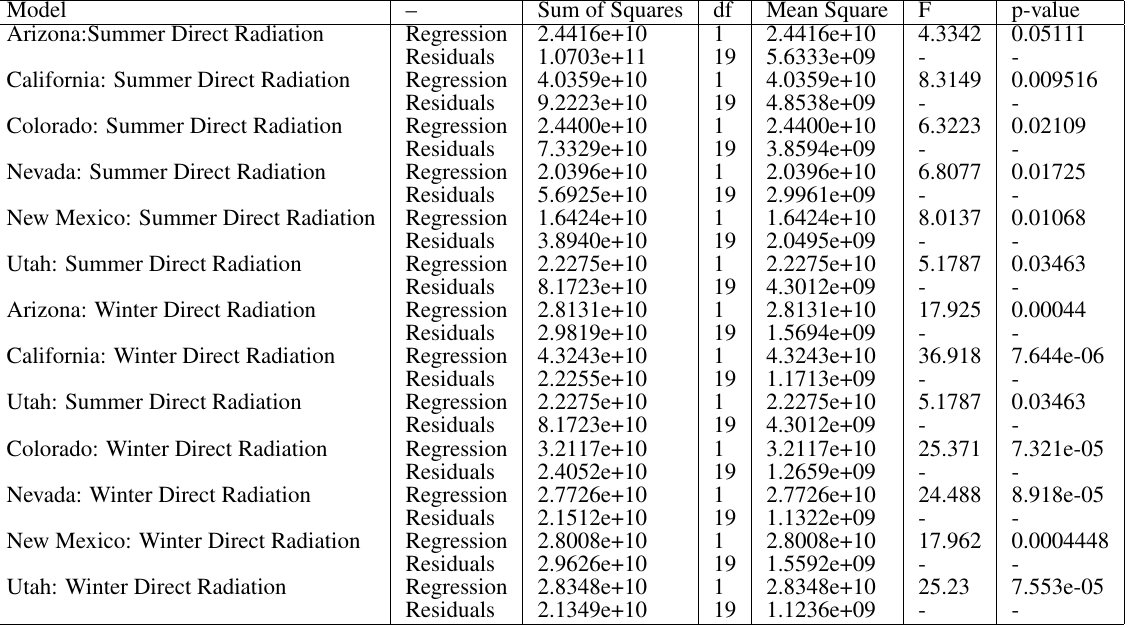
Table 7. Analysis Regression for predictions relationship between variable by the ANOVA